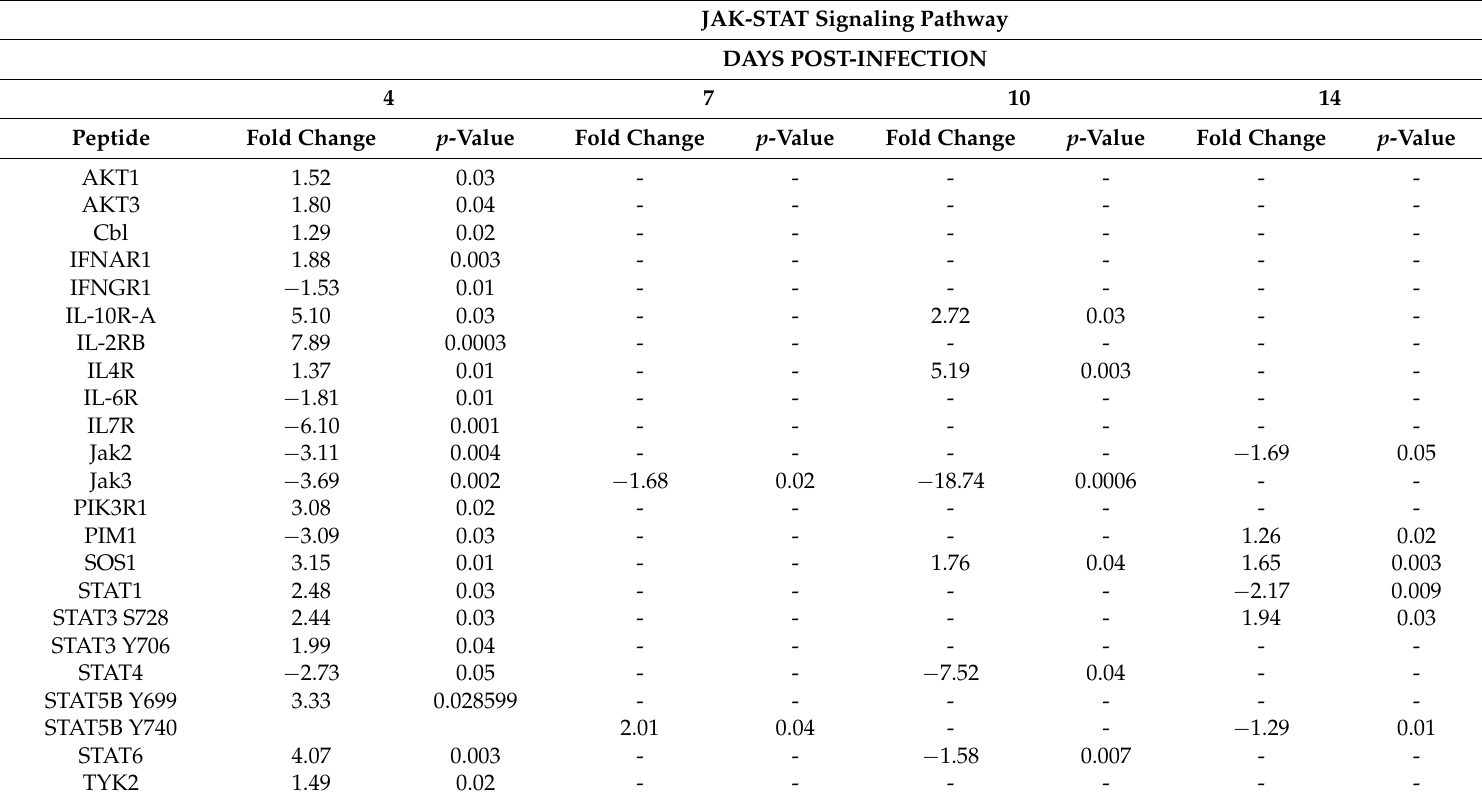
Peptides that displayed a p -value of less than 0.05 are